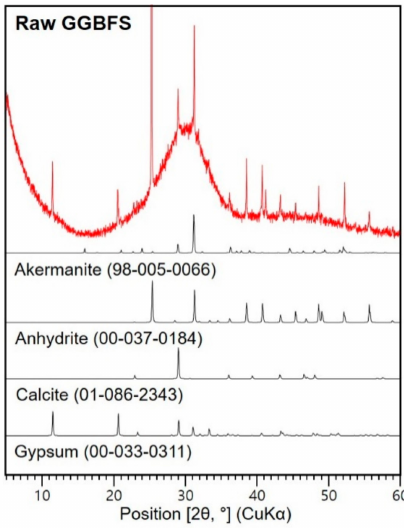
Figure 1. X-ray di ff raction (XRD) patterns of raw ground-granulated blast-furnace slag (GGBFS).